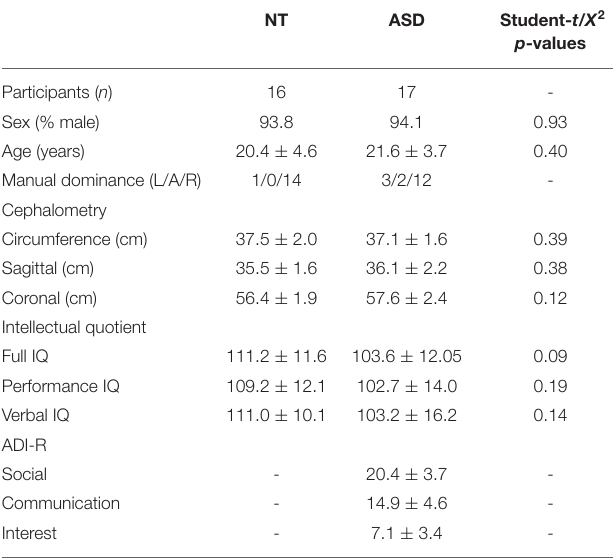
TABLE 1 | Demographic, biometric, and clinical characteristics.